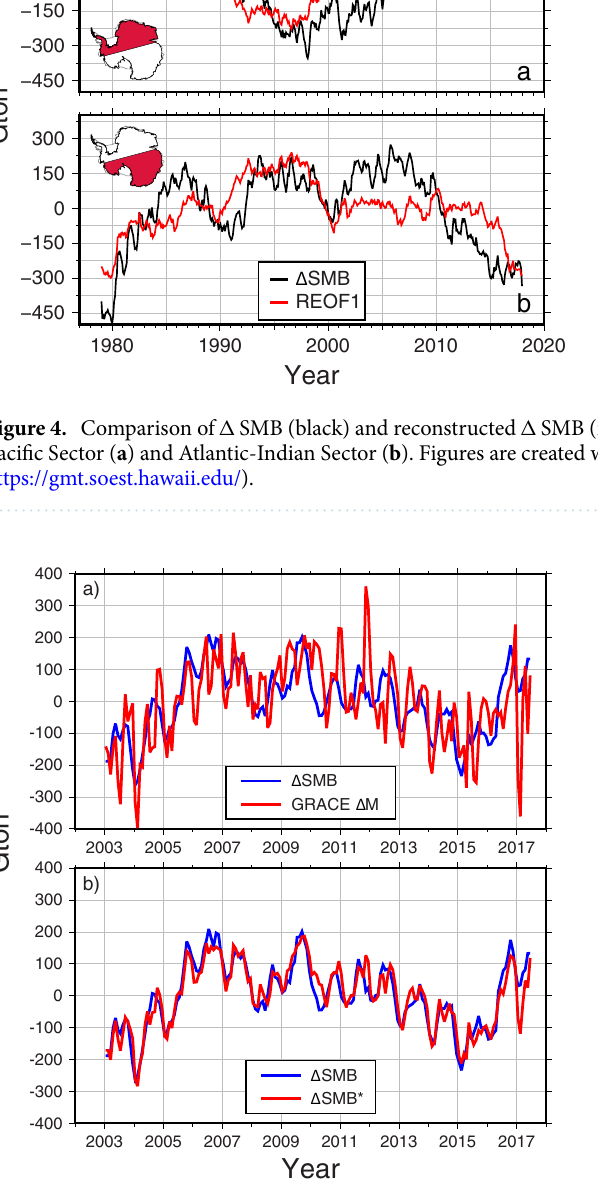
Figure 5. ( a ) Comparison between (cid:31) SMB (blue) and GRACE mass estimates (cid:31) M (red). ( b ) Similar to ( a ) but (cid:31) SMB * is the estimated (cid:31) SMB from (cid:31) M after ice discharge and barometric pressure error corrections. Figures are created with Generic Mapping Tools (GMT-5.4.5, https ://gmt.soest .hawai